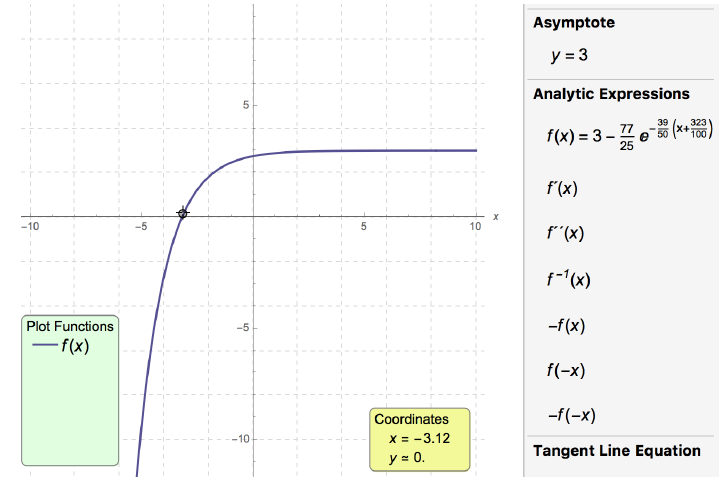
Figure 18. Image that illustrate part of an evaluation task: graphical representation of the inverse function whose function is drawn and analytical determination of that function.